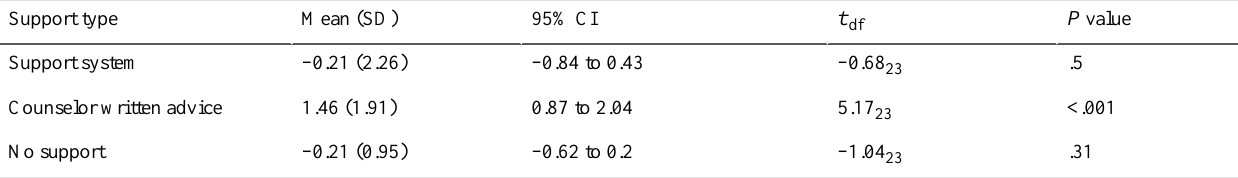
Table 3. One-sample t test for counselor utility ratings per support types